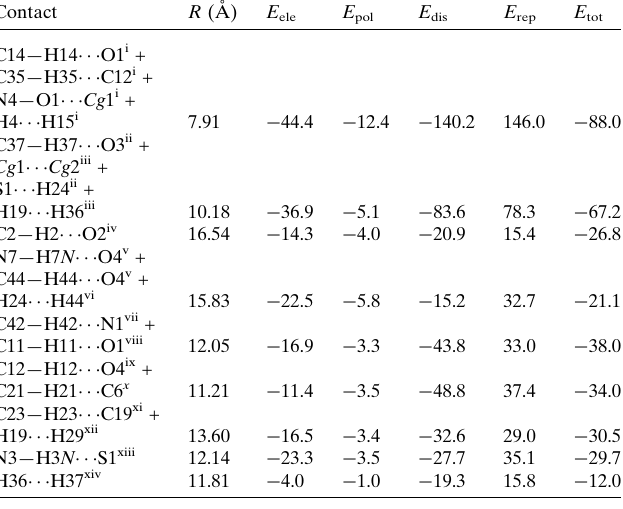
Table 5 A summary of interaction energies (kJ mol (cid:4) 1 ) calculated for (I). Contact R (A˚ )